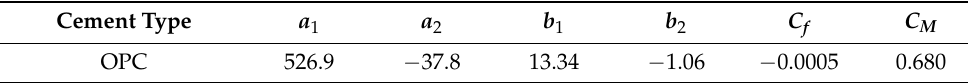
Table 4. Coefficients of Ordinary Portland cement.